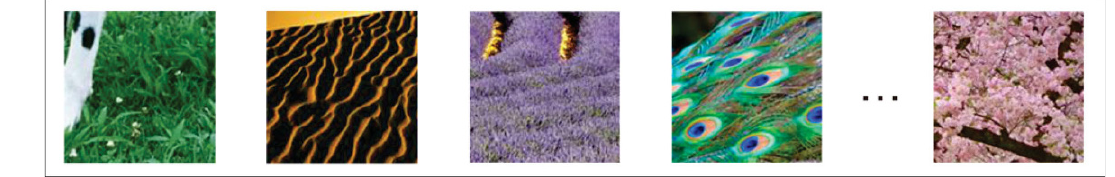
Fig. 6 Local color deficiencies in texture